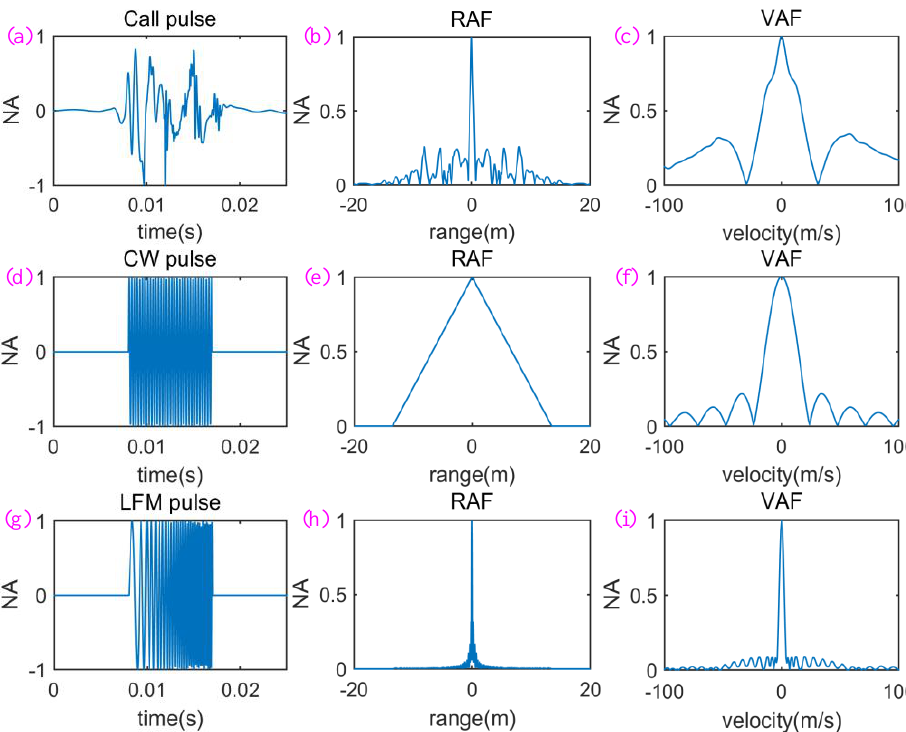
Figure 6. A comparison of RAF and VAF among the sperm whale call pulse, CW pulse, and LFM pulse. ( a ) Waveform of call pulse; ( b ) RAF of the call pulse; ( c ) VAF of the call pulse; ( d ) waveform of CW pulse with 3.5 kHz carrier; ( e ) RAF of the CW pulse; ( f ) VAF of the CW pulse; ( g ) waveform of LFM pulse with a frequency range from 0.5 kHz to 6 kHz; ( h ) RAF of the LFM pulse; ( i ) VAF of the LFM pulse.